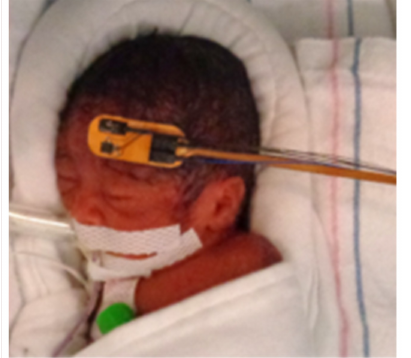
Figure 3. Picture of an extremely preterm infant during a continuous-monitoring diffuse correlation spectroscopy measurement with the presented contact-sensitive optical probe. The measurement was performed in the Giraffe incubator in a neonatal intensive care unit.